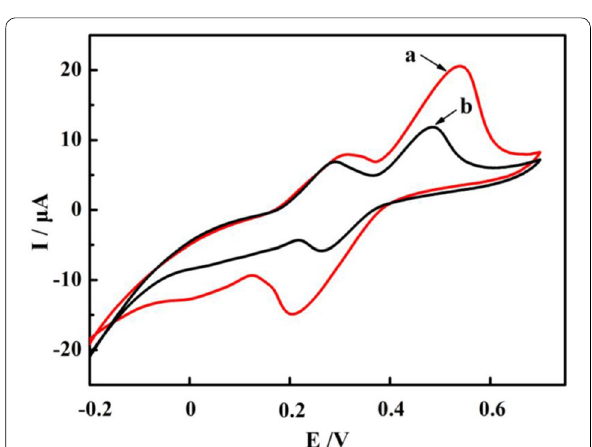
Fig. 4 Cyclic voltammetry of PVA/Fe 3 O 4 -Laccase–TEMPO GC (a) and PVA/Fe 3 O 4 -Laccase GC (b). The anodic peak potential of PVA/ Fe 3 O 4 -Laccase–TEMPO modified GC electrode shifted to a more positive value and the cathodic peak potential shifted to a lower negative